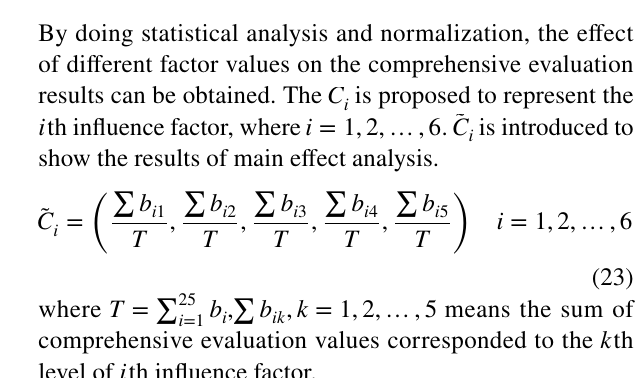
Fig. 9 Weight calculation results of each level in each factor in 3D view Table 5 Membership degree and comprehensive evaluation value